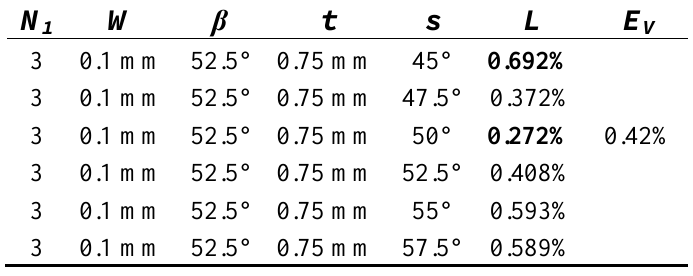
Table 8. Nonlinearity errors of the sensors with different spans of the rotors